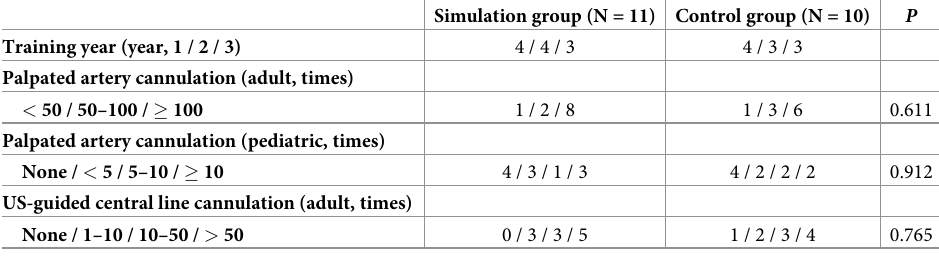
Table 1. Baseline characteristics of anesthesiology